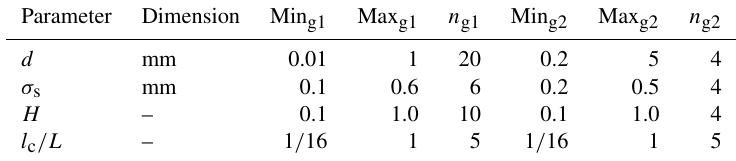
Table 1. Minimal and maximal input values for parameters d , σ s , H , and l c /L . n denotes the total number of increments, including minimum and maximum. Subscripts g1 and g2 indicate data for group 1 or 2, respectively. Thus, multiplying the n values of each parameter gives the total number of parameter combinations (6000 for group 1, 320 for group 2). The number of realizations for a set (i.e., the number of different random number seeds used to generate the surfaces with one peculiar parameter combination) are given in the footnotes, resulting in a total of 600000 and 6400 fracture configurations for groups 1 and 2, respectively. Parameter Dimension